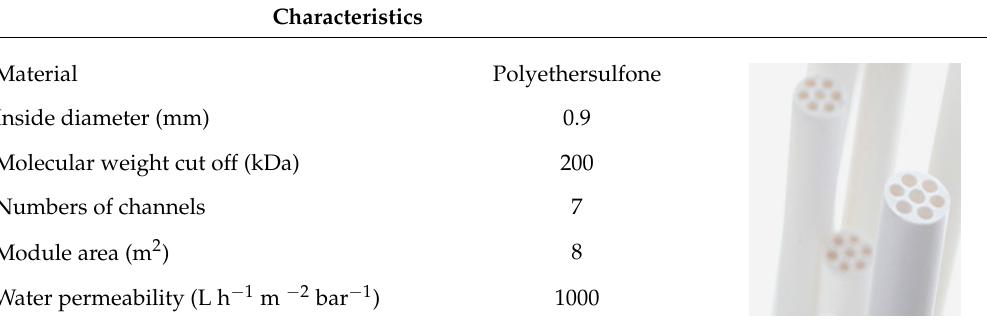
Table 2. Membrane characteristics.